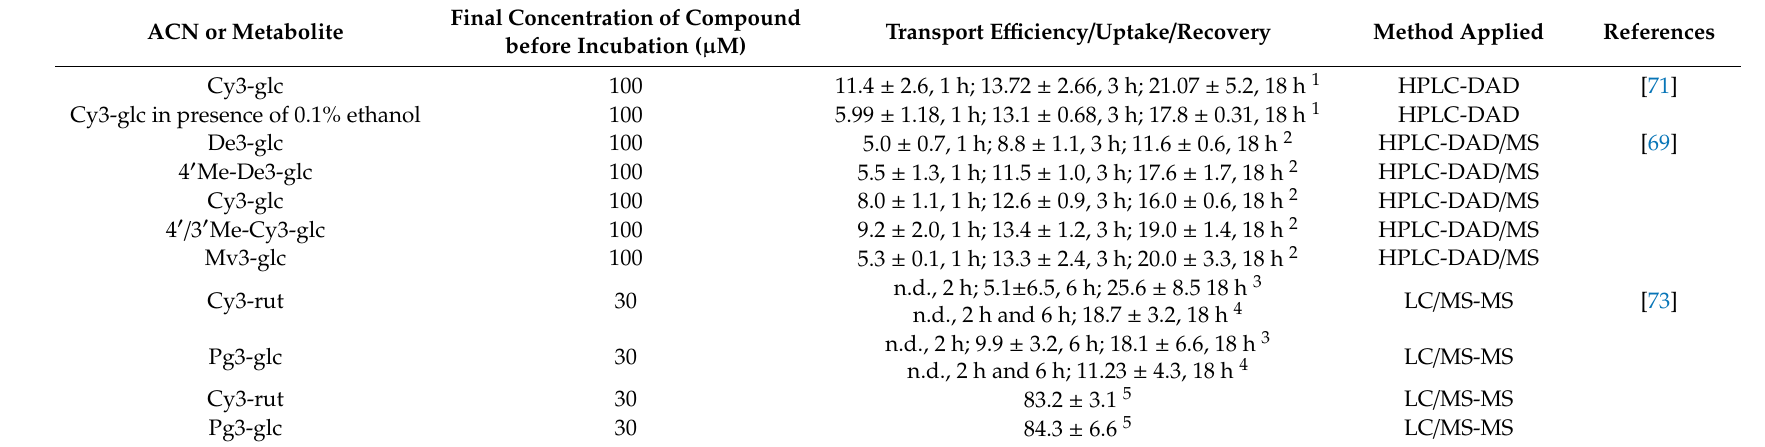
Table 2. The evaluation of interaction between the anthocyanins (ACN), and some of their metabolites and the blood–brain barrier (BBB): in vitro studies. ACN or Metabolite